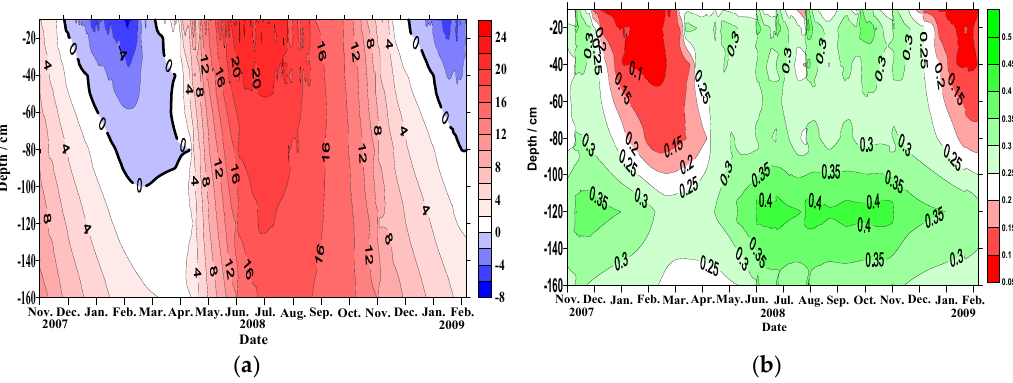
Figure 5. Seasonal variations in the soil temperatures ( a , °C) and soil moisture content ( b , m 3 ∙ m − 3 ) at the Yingke site from November 2007 to January 2009. Table 4. Seasonal average and range in the soil moisture content (m 3 ∙ m − 3 ) at various depths at the Yingke site from November 2007 to January 2009. Soil Depth